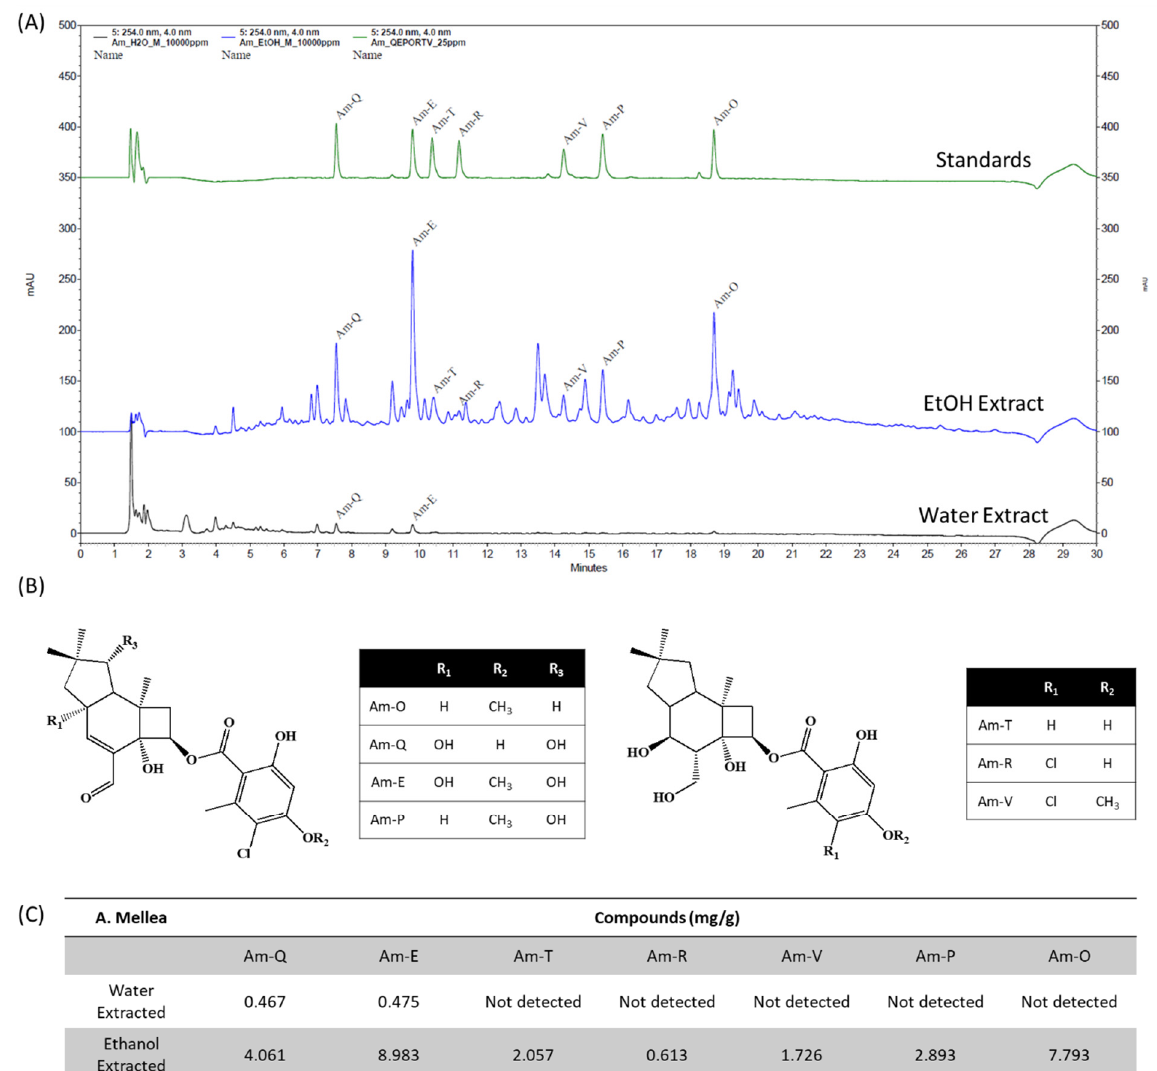
Figure 3. Quantification of compounds in water and ethanol extracted A. Mellea . ( A ) HPLC based peak chromatograms at 254 nm, ( B ) chemical structure of components and ( C ) quantification of identified compounds from ethanol and water extracts of A. Mellea . Am-Q: Melledonal B; Am-E: Melledonal C; Am-P: Armillarikin; Am-T: Armillane; Am-R: Melleolide Q; Am-V: 6 ′ -Chloro-5 ′ -methoxy-armillane; Am-O: Armillaridin.